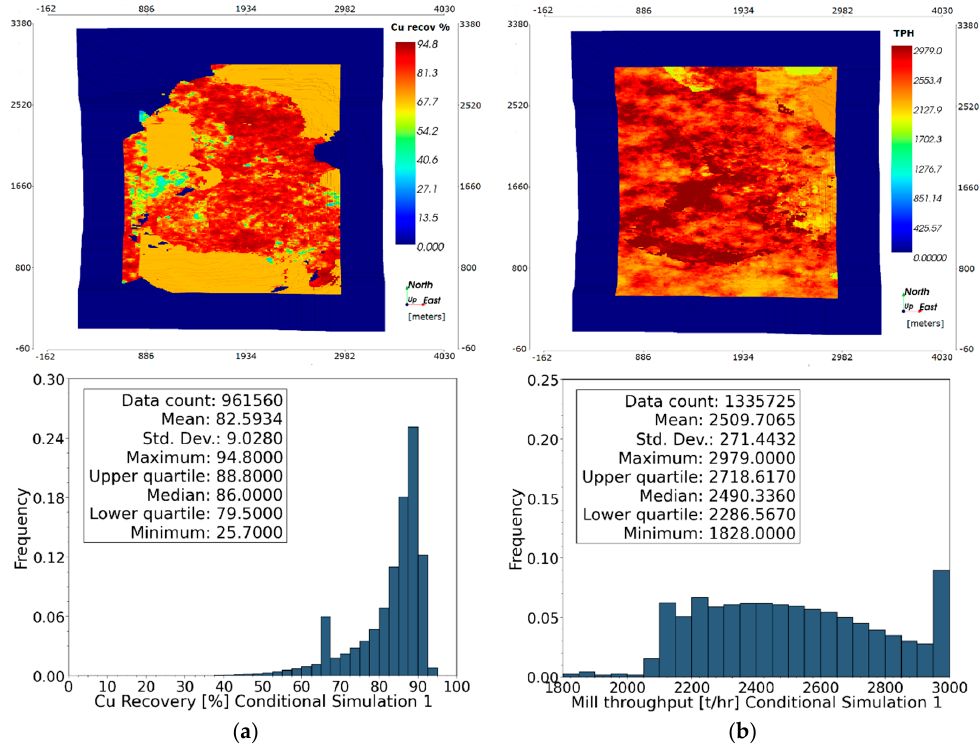
Figure 8. Plan view of geometallurgical models (top) with the associated histogram (bottom) for realization 1. Variables: ( a ) Cu metallurgical recovery (%) and ( b ) throughput rate (ton/h).